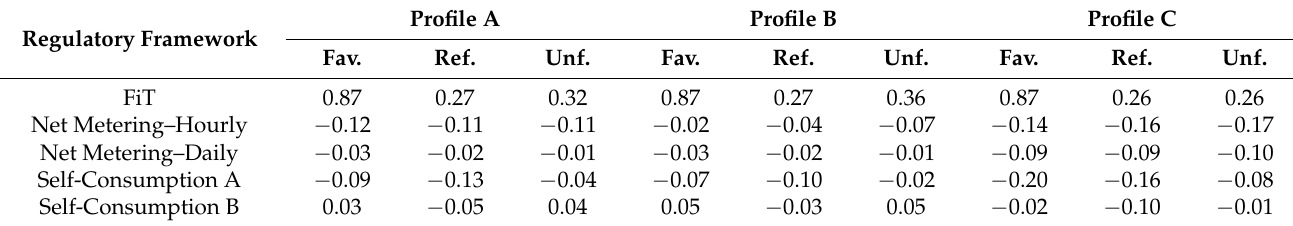
Table 6. Difference between the individual benefit and the mean benefit within a community, in € /day, for all profiles and regulatory frameworks considered in systems with ESS. Source: